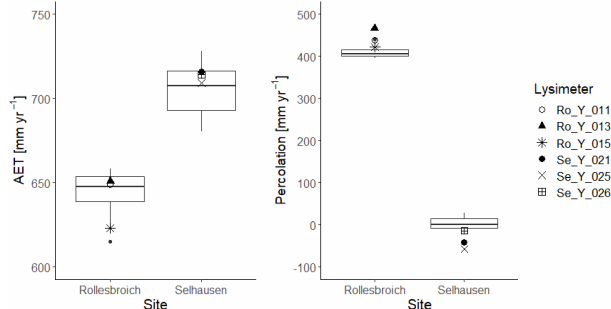
Figure 6. Box-and-whisker plots of simulated annual average evap- otranspiration (AET) and percolation at Selhausen and Rollesbroich for the period 2013–2018 for the 30 acceptable simulations com- pared with the lysimeter measurements (large symbols). For an ex- planation of the box-and-whisker plots, see the caption of Fig.